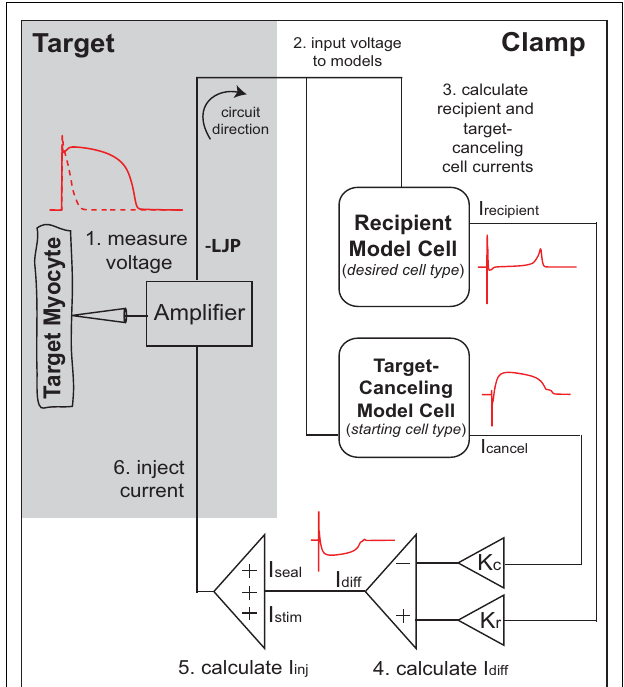
FIGURE 1 | Cell-type transforming clamp circuit (adapted from Ahrens-Nicklas and Christini, 2009 with permission from Elsevier). A real cell (target myocyte) is simultaneously coupled to a target-canceling computational model (a model of the native isolated cell) and a recipient computational model (a model of the desired cell-type, i.e., human or guinea pig), in a closed-loop circuit. A time-dependent current that compensates for the difference between target cell and recipient model cell currents is inserted into the myocyte at each instance of the measured voltage.The myocyte responds to the injected current such that the membrane voltage is transformed to the recipient model. An offset was added to correct the measured voltage for the liquid junction potential